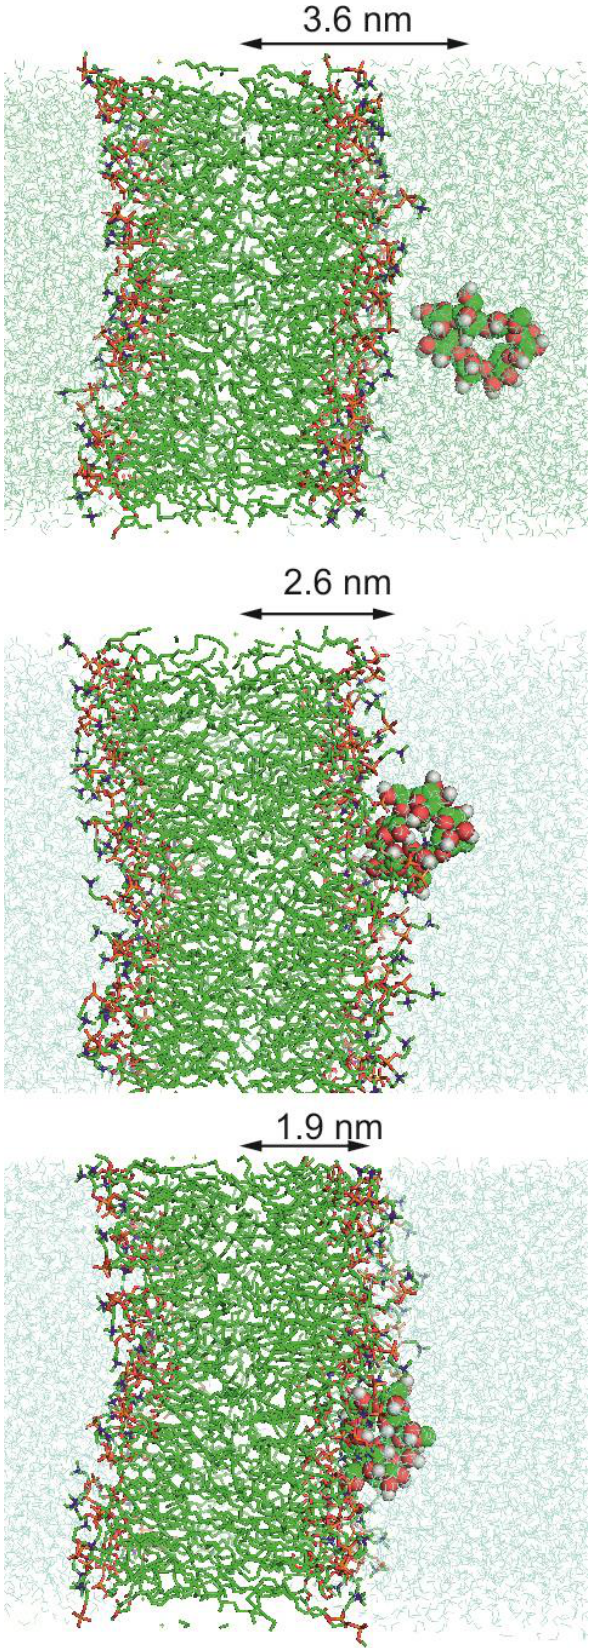
Figure 4. Snapshots taken from US calculations representing three different distances between β-CD and bilayer.